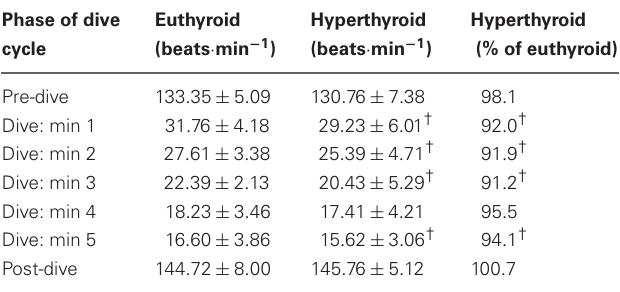
Table 3 | Estimated total body O 2 stores, cADL, and maximum observed dive duration for seals in the euthyroid and hyperthyroid